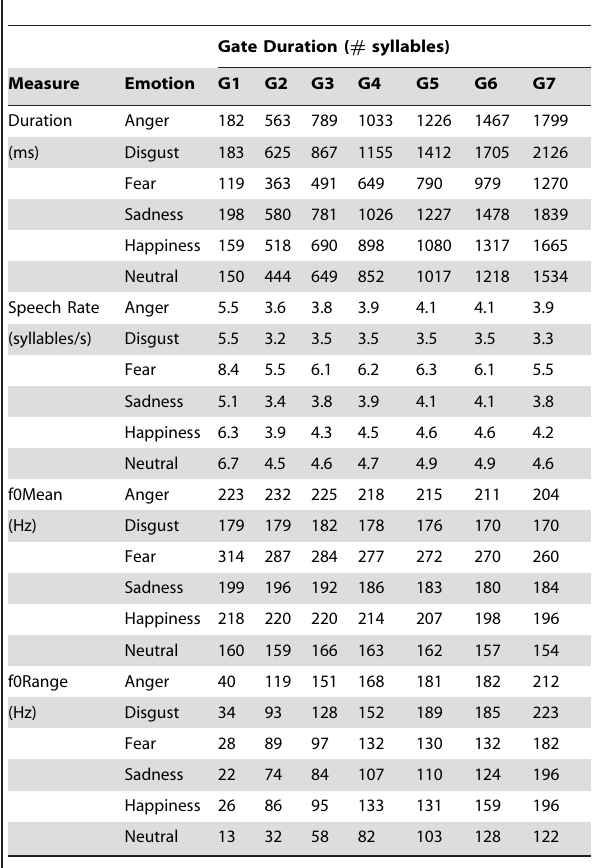
Table 1. Acoustic features of the experimental stimuli (measured from sentence onset for each